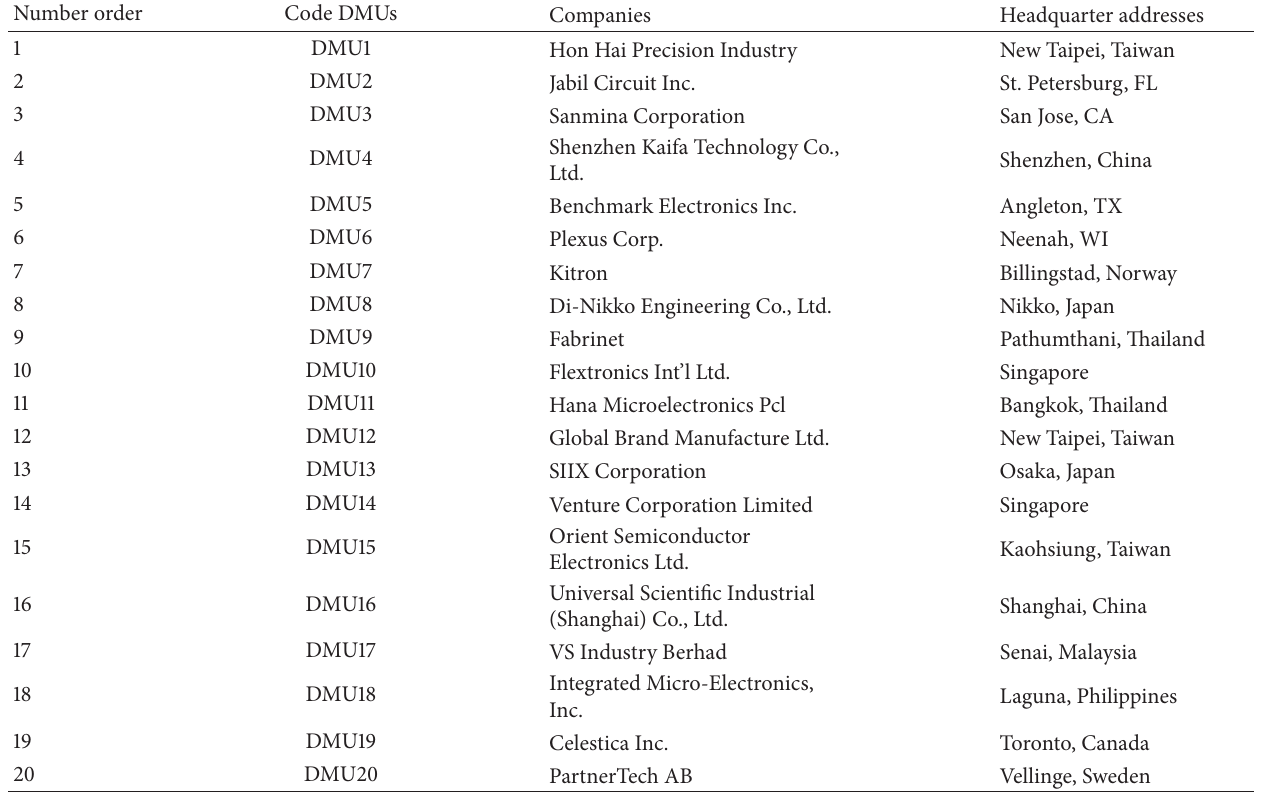
Table 1: List of EMS